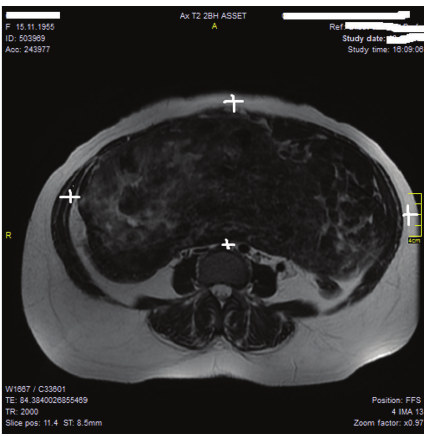
Figure 1: The figure shows MRI image of giant pelvic mass filling whole abdominal cavity with heterogenous and semisolid appearance (corresponding the image between four white callipers).